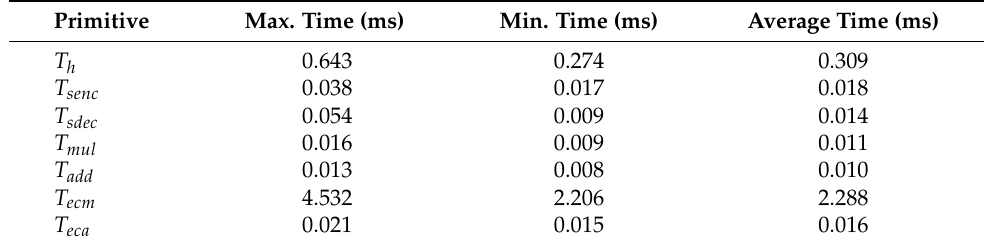
Table 3. Execution time (in milliseconds) of cryptographic primitives under Raspberry PI 3